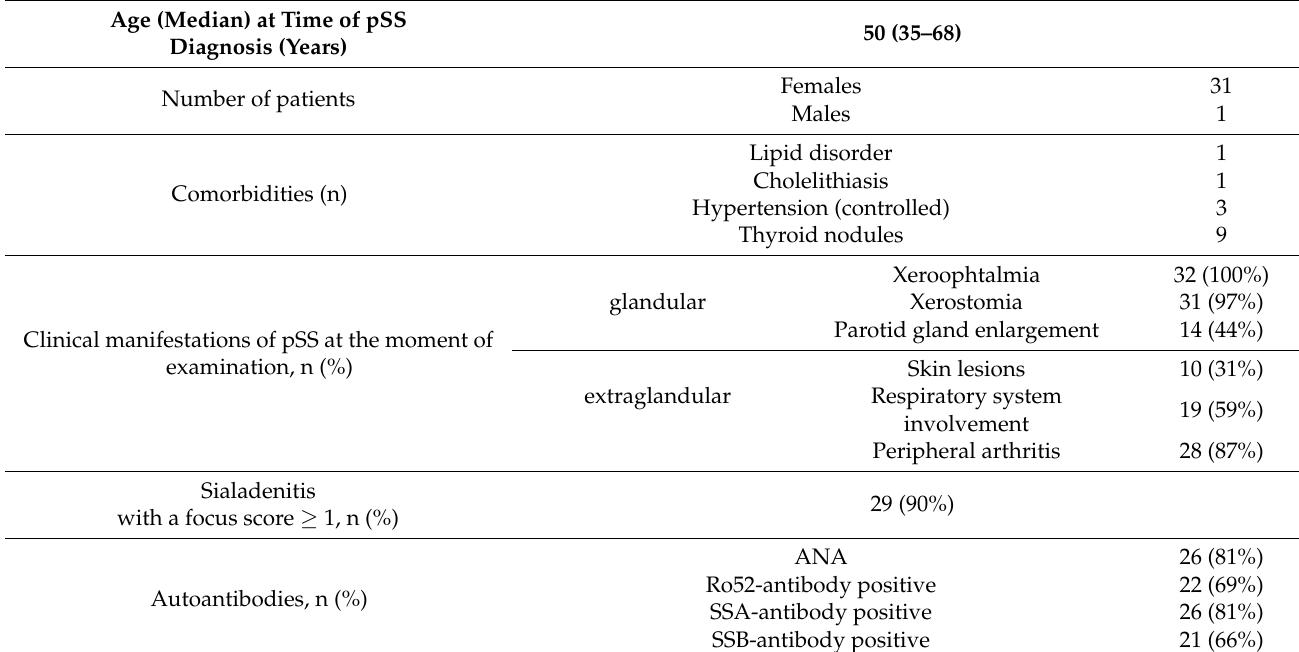
Table 1. The baseline characteristics of patients with primary Sjögren syndrome